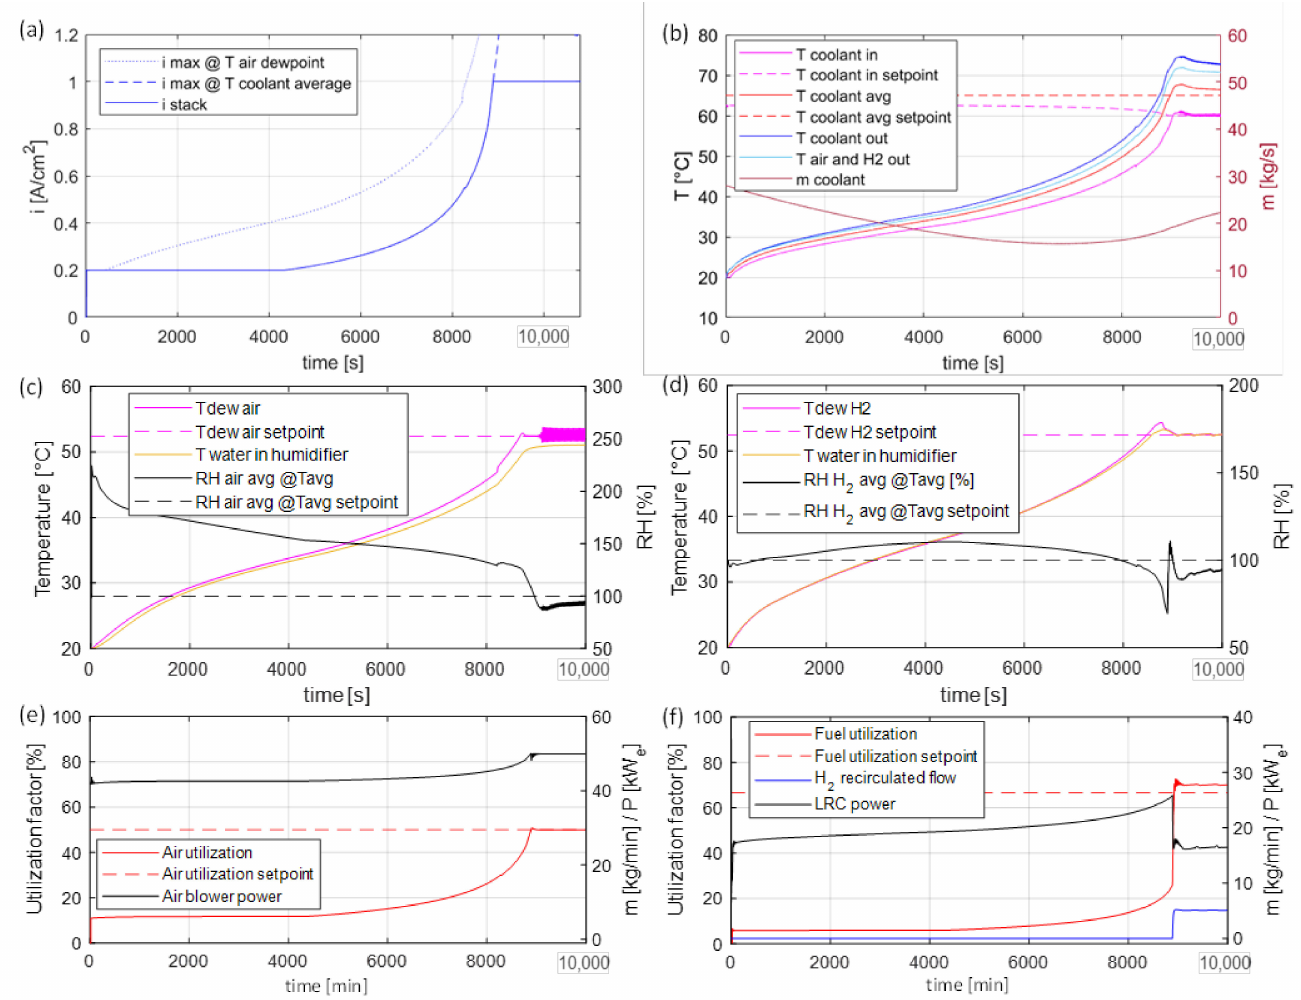
Figure 7. Warm-up simulation: time profile of ( a ) current density vs its maximum values according to the air dewpoint temperature and the average coolant temperature; ( b ) coolant temperature at stack inlet vs setpoint, average coolant temperature over the stack vs setpoint, coolant temperature at stack outlet, air and hydrogen temperature at stack outlet and coolant flowrate; ( c )/( d ) air/hydrogen dew point temperature at stack inlet vs setpoint, water temperature in the air/hydrogen humidifier tank, and air/hydrogen average RH vs setpoint; ( e ) air utilization factor and setpoint, and air blower power consumptions; ( f ) fuel utilization factor vs setpoint, mass flowrate of hydrogen recirculated over the LRC, and LRC power